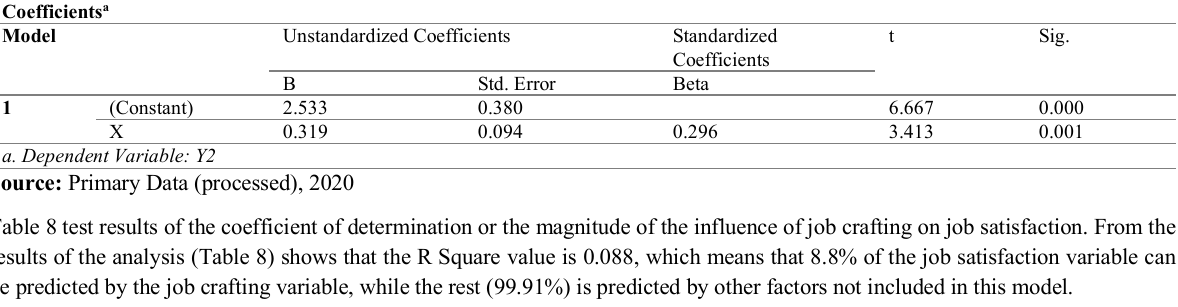
Table 7 analysis results of the effect of job crafting on job satisfaction using simple linear regression analysis tools. The results of the analysis show that the significance value of 0.001 is less than 0.05 (p <0.05), it can be concluded that job crafting has a significant